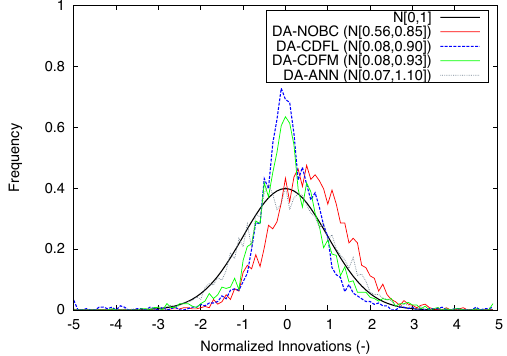
Figure 11. Average seasonal cycle of the RMSE for surface soil moisture from the open loop, and various DA integrations relative to the Control simulation.